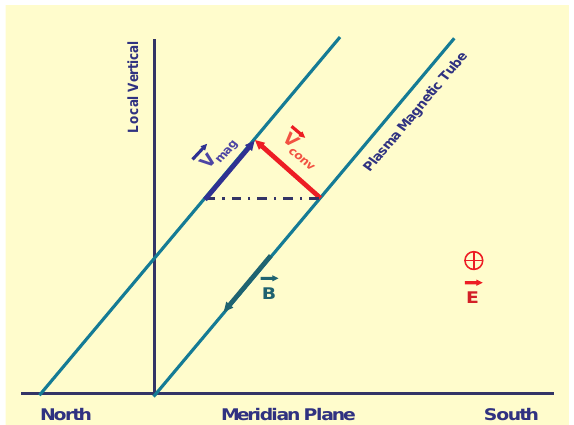
Fig. 2. Sketch explaining the presence of a velocity component V mag along the magnetic field-line resulting from the ion convec- tion drift V conv .